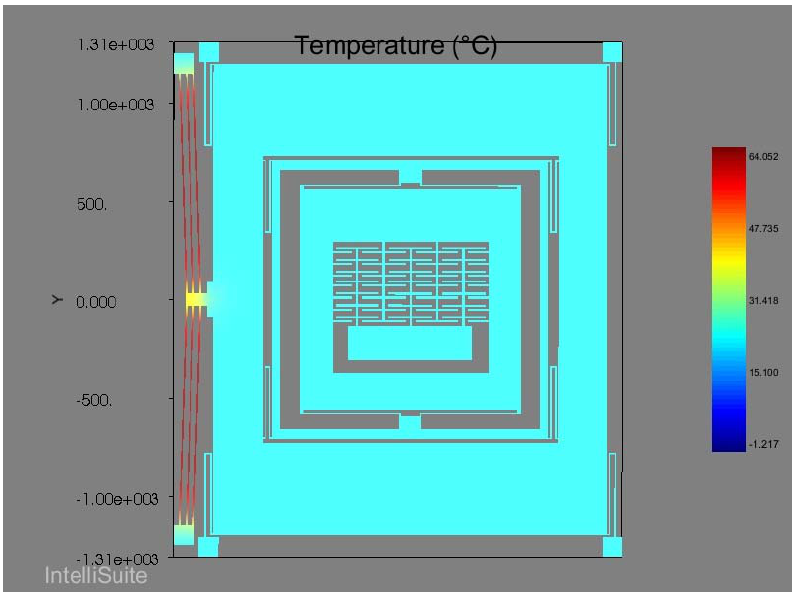
Figure 17. Temperature profile of the 3-DoF micromachined vibratory gyroscope when excited by a sinusoidal voltage of 0.5V amplitude and a frequency of 1.77